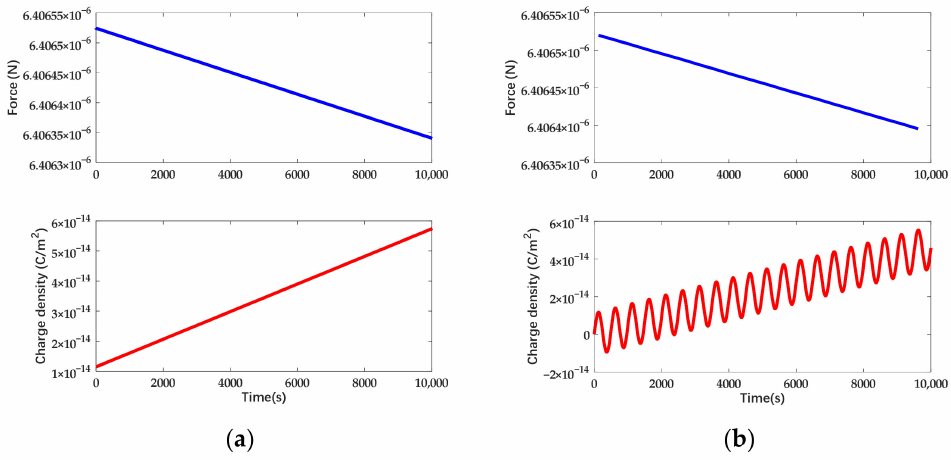
Figure 15. Charge density and electrostatic force variation in time domain while the deposited charge is increasing. The actuation voltage is asymmetrical and the deviation voltage is 1 mV: ( a ) Applying DC actuation; ( b ) Applying AC